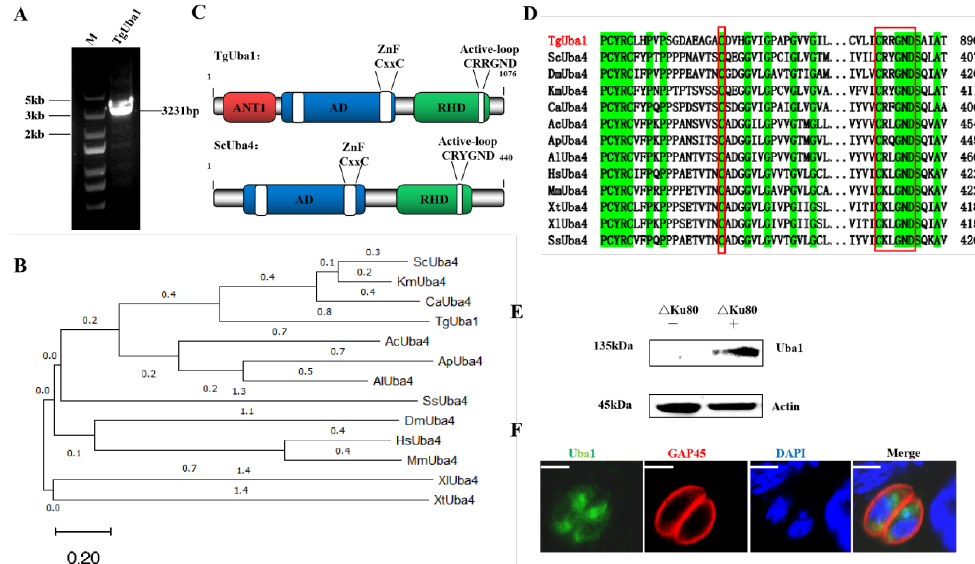
Figure 1. Identification and cellular localization of TgUba1. ( A ) PCR amplification of TgUba1. The full length is 3231 bp. ( B ) Phylogenetic analysis of TgUba1 with MEGA 11.0 tool. The sequence ac-